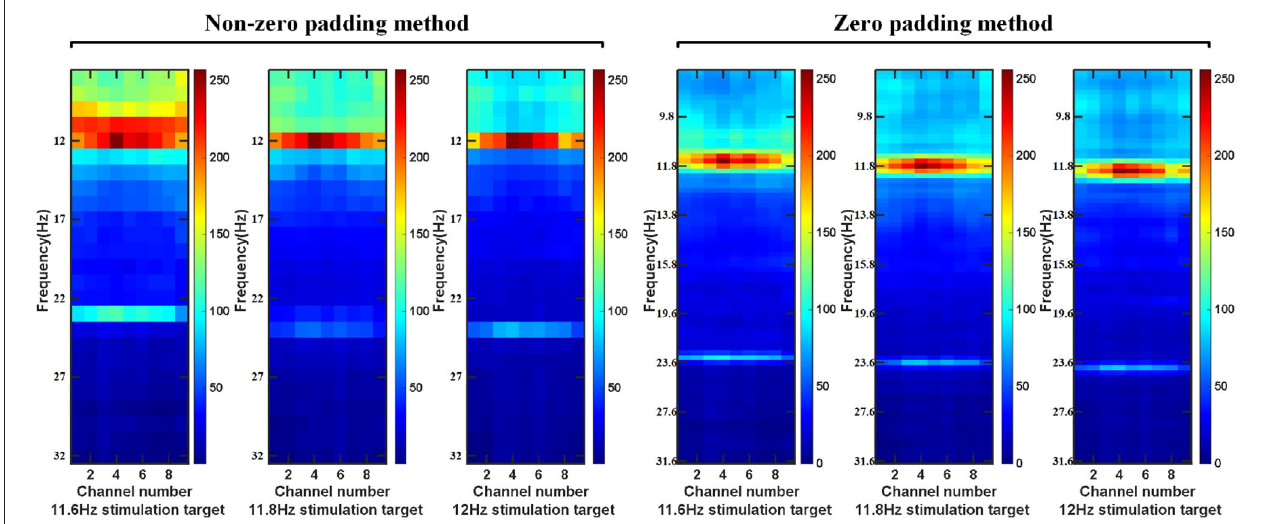
FIGURE 4 | In BETA:SSVEP dataset, feature matrix after superposition and average of PSD without zero-padding and PSD with zero-padding.